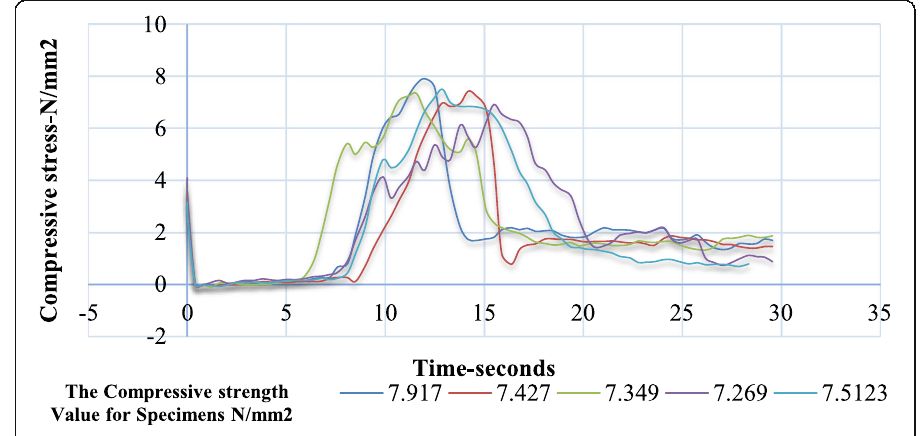
Fig. 11 Compressive strength test results — steel filing ratio